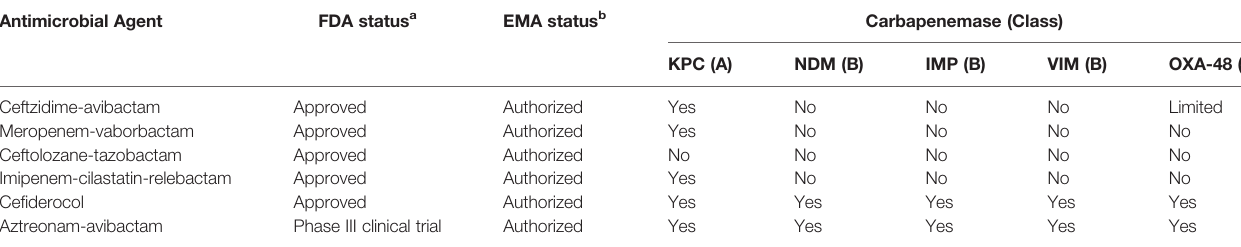
TABLE 1 | Activity of recent beta-lactam/beta-lactamase inhibitor combinations against microorganisms containing carbapenemases a . Antimicrobial